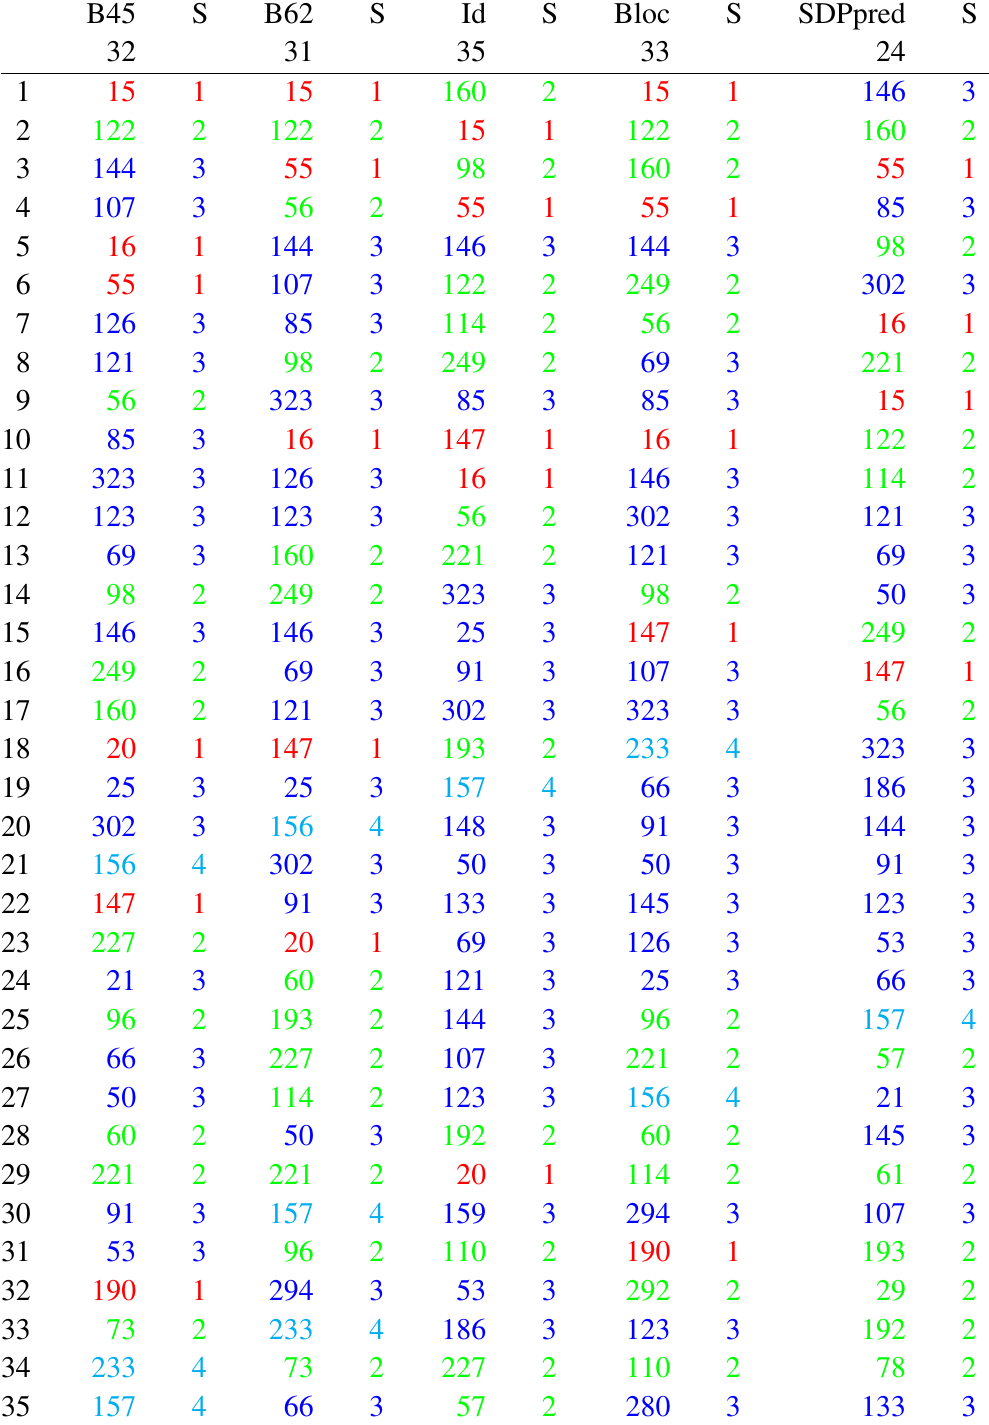
Table 3. SDPs inferred from 54 members of the LacI family. The Table shows the 35 best ranking SDPs that characterize the LacI family of bacterial transcription factors. Column labeling and second row content as in Table 1. Details on the scores S can be found in the text. Positions with different scores are colored in different colors to facilitate reading. Numbering follows E. Coli PurR in 1WET PDB